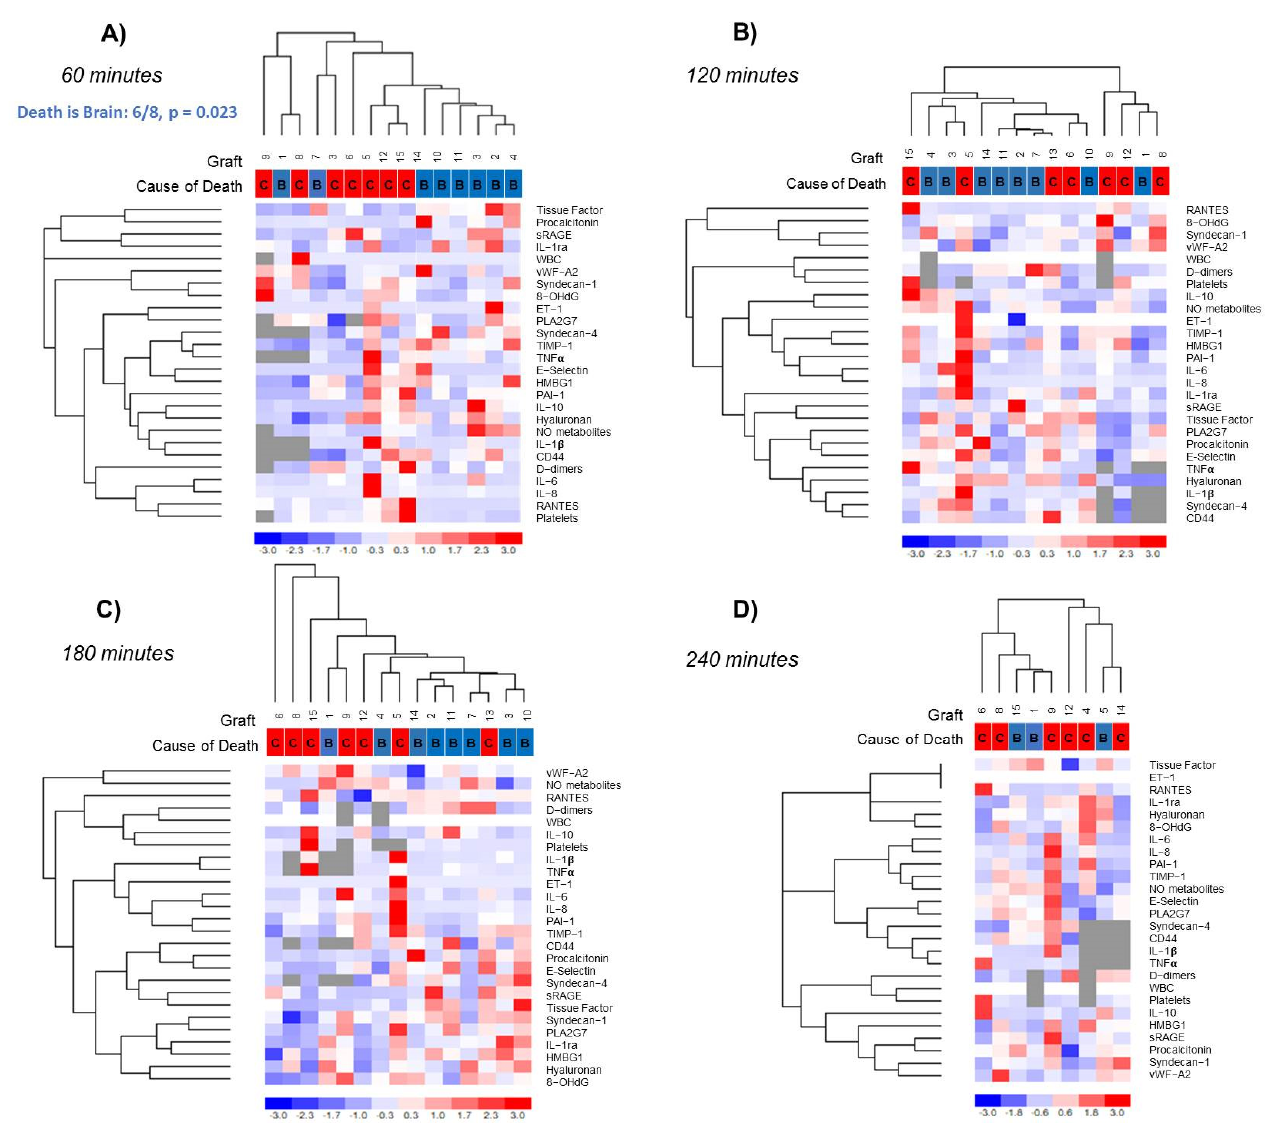
Figure 3. Hierarchical cluster analysis of analyte perfusate concentration. Agglomerative hierarchical clustering was performed to investigate whether a donor-specific signature could be identified in the molecular profile of the perfusate. Independent analyses were carried out at ( A ) 60, ( B ) 120, ( C ) 180, and ( D ) 240 min. Unsupervised analysis revealed a donor-specific pattern at 60 min, with six out of eight EC-DBD patients grouped in a single cluster ( p = 0.0230). This distinctive profile was not recognizable at the subsequent time points. Cause of death was referred to as B for EC-DBD (blue) and C for DCD (red) donors. Cluster analysis was performed using dCHIP software (clustering method: average linkage; distance metric: 1—Spearman’s rank correlation). Columns identify cases, while rows denote the parameters evaluated in perfusate. The degree of color saturation reflects the magnitude of the mediator concentration, as indicated in the color scale.